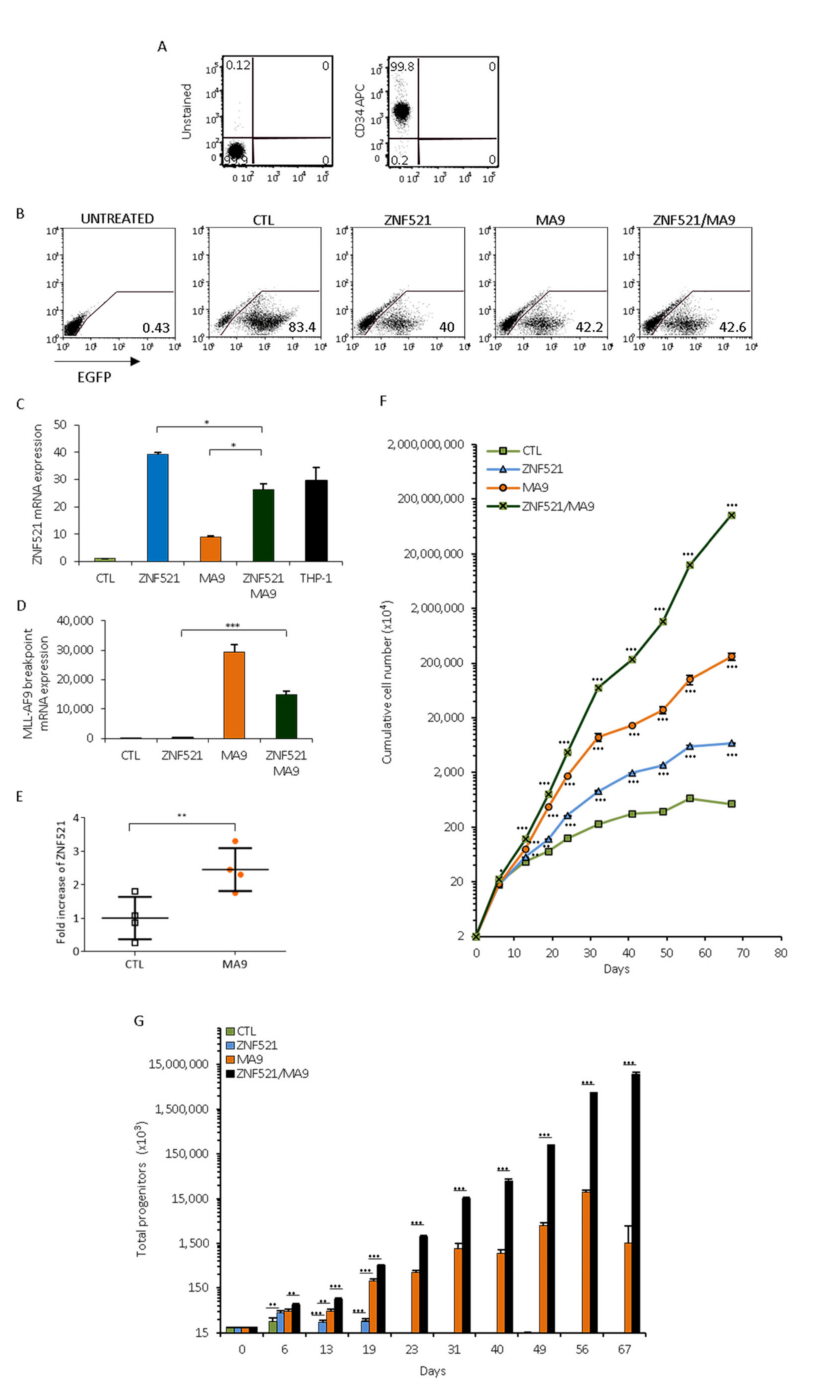
Figure 2. CB-CD34 + transduced cell expansion in vitro.( A ) Purified cord blood hematopoietic progenitor cells were characterized by FACS for the CD34 antigen. ( B ) FACS analysis of transduced cells was performed to evaluate the percentage of E-GFP positive cells at 6 days after transduction. The transduction efficiency of CD34 + cells was evaluated by Q-RT-PCR analysis: mRNA levels of ( C ) ZNF521 and ( D ) the MLL-fusion gene are significantly enhanced in transduced cells compared to control cells. ( E ) In four different MLL-AF9 transductions of CB-CD34 + cells, the amounts of ZNF521 mRNA are shown (analyzed at 37 days). ( F ) CB-CD34 + cells (2 × 10 4 ) were plated in MyeloCult™ complete with cytokines. Cumulative cell expansion is shown, and the p -value is calculated compared to control vector. All assays were performed in triplicate. ( G ) Colony-forming cell (CFC) assays were performed using StemMACS HSC-CFU medium complete with cytokines. Colonies were scored after 2 weeks, and the number of progenitors was normalized to the total cell number in the relevant culture at the time of plating. Data are represented as mean ± SD (* p < 0.05, ** p < 0.01, *** p <